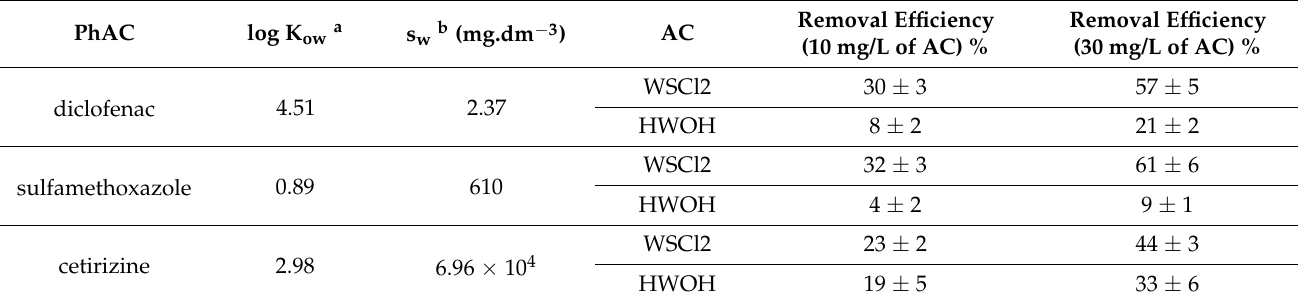
Table 6. Removal efficiencies of diclofenac, sulfamethoxazole, and cetirizine from the mixture of these pharmaceuticals after 60 min experiments on 10 mg/L and 30 mg/L of WSCl2 and HWOH,